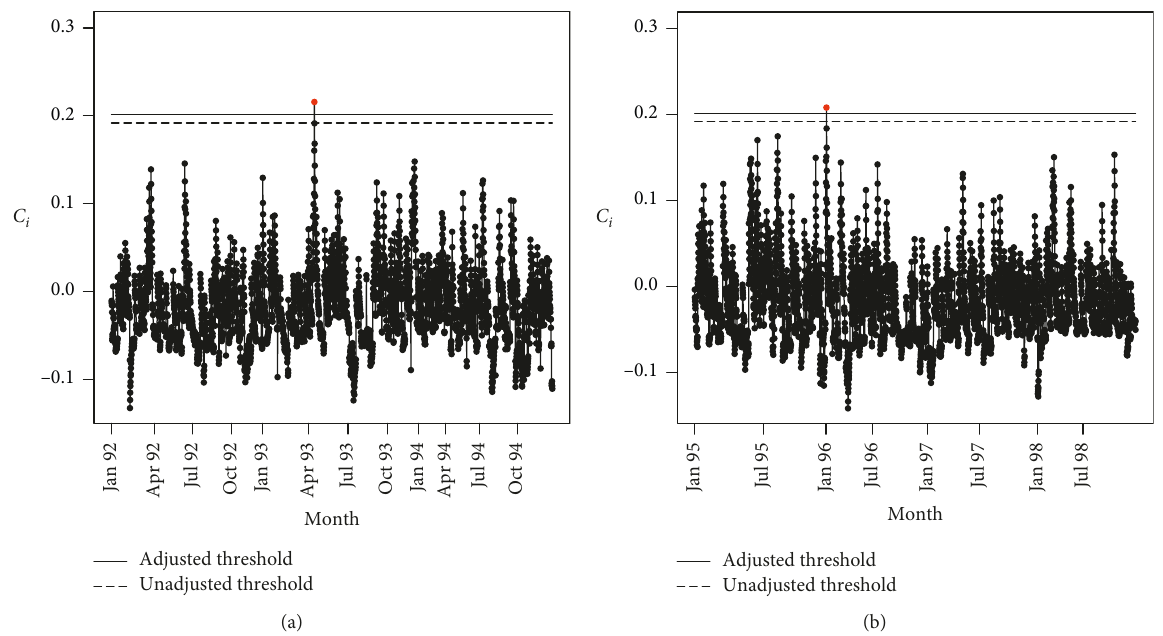
Figure 11: RA-EWMA chart for Phase-I and Phase-II assuming first three years as the Phase-I for 30 days mortality of cardiac surgery patients. (a) Phase-I chart, unadjusted UCL � 0.1918 and adjusted UCL � 0.2015. (b) Phase-II chart, unadjusted UCL � 0.1918 and adjusted UCL �